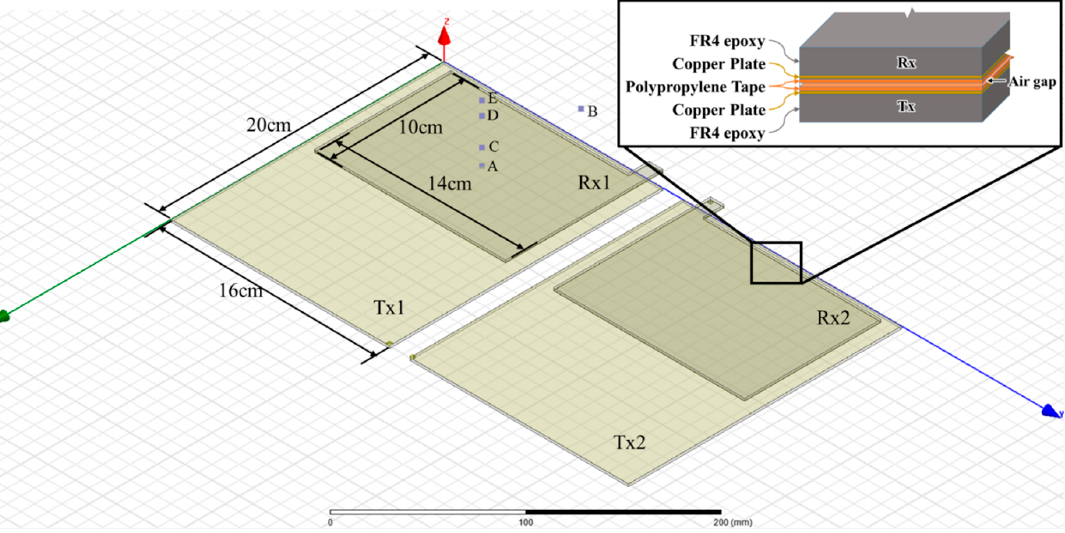
Figure 9. Plates modelling in Ansys Maxwell. Table 2. Measurement points coordination.